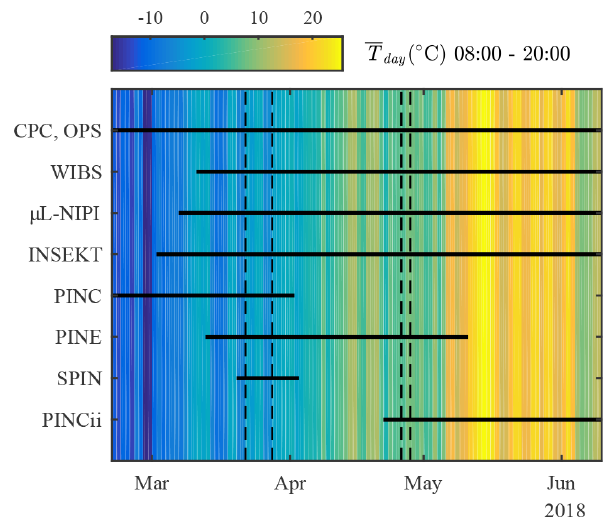
Figure 2. Timeline of deployment for the instrumentation installed specifically for the HyICE-2018 campaign. Shading depicts mean daytime air temperature T day (08:00–20:00, UTC+2) measured at 4.2m above ground level. Instrument inter-comparison days are in- dicated by the dashed